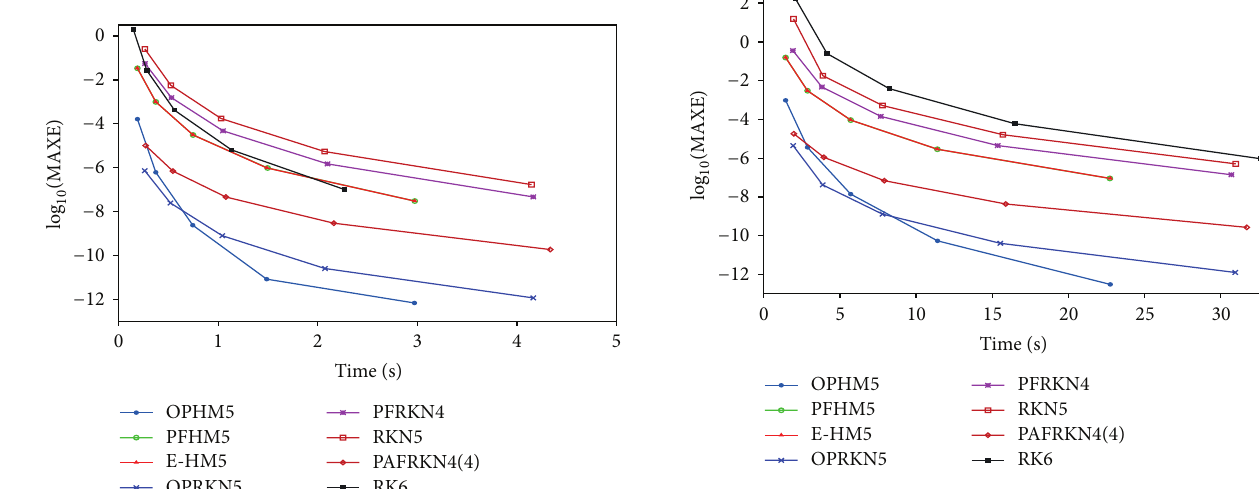
Figure 4: The efficiency curves of the optimized and phase-fitted order five methods and their comparisons for Problem 5 with 𝑡 10 4 and ℎ = 0.125/2 𝑖 , 𝑖 = 2,...,6 = end